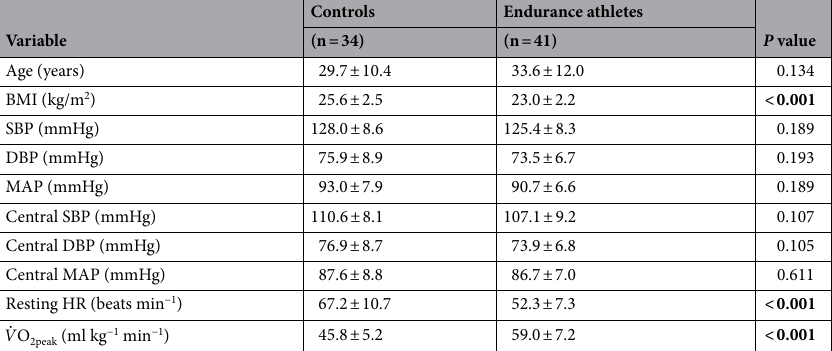
˙ V O 2peak . BMI, ˙ V O 2peak ,